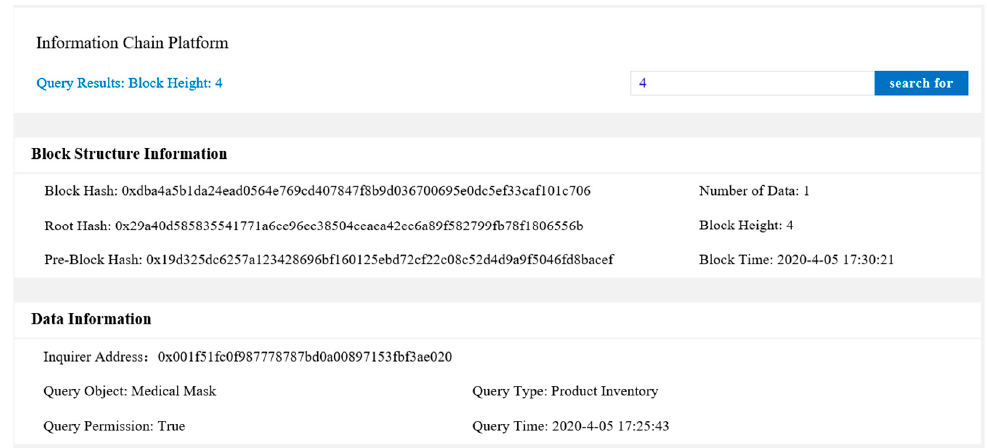
Figure 12. Records fetched.